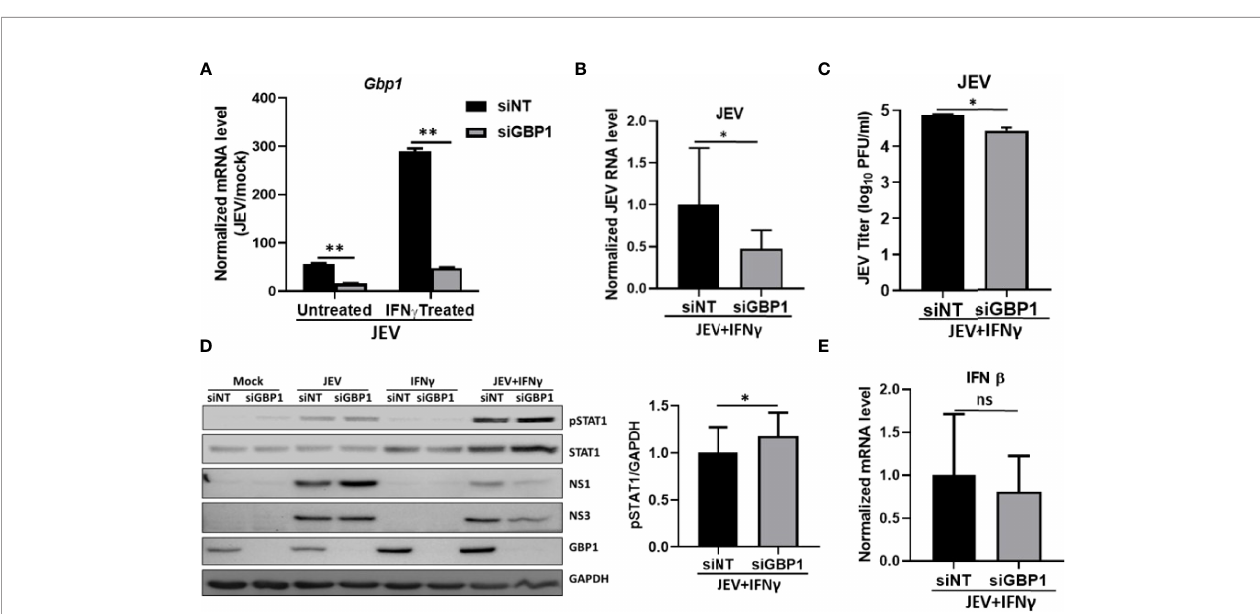
FIGURE 3 | GBP1 depletion reduces JEV replication and increases STAT1 and pSTAT1 levels in an IFN g primed environment. HeLa cells were transfected with NT/GBP1 siRNA for 48 h, followed by IFN g treatment for 12 h and then mock or JEV infected at 1 MOI for 24 h. GBP1 mRNA (A) , and JEV RNA (B) levels were determined by qRT-PCR. (C) Virus titer was determined by plaque assays. (D) Cell lysates were analysed by western blotting with STAT1, pSTAT1, JEV non- structural proteins (NS1 and NS3), GBP1 and GAPDH (loading control) antibodies. The bar graph shows the levels of pSTAT1 protein in siNT- and siGBP1- treated HeLa cells from three independent experiments. The protein quantitation was done by measuring the band intensities using ImageJ software. (E) IFN b mRNA levels were checked through qRT-PCR. Data presented is mean ± SD of values obtained from 3 independent experiments. Student t-test was used to calculate P values. * P < 0.05, ** P < 0.01. ns, Non signi fi